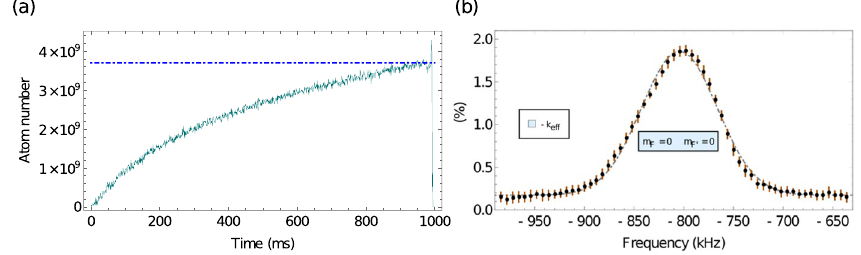
Figure 8. 3D MOT loading rate and temperature determination. ( a ) Loading rate of the 3D MOT. At one second, we measure 3.7 × 10 9 atoms - the initial loading rate is 8.0 × 10 9 atoms. ( b ) Temperature determination after launching and cooling. We fit a Gaussian model to the distribution - the gray dot-dashed curve is the fit. Each data point, in black, is the mean of ten measurements and the error bar, in orange, is the standard deviation of those ten measurements. We measure a temperature of 2.3 μ K along the axis of the Raman beam, with no velocity preselection, using a 94 μ s π -pulse. This feature is the Δ m F = 0, − k eff Doppler sensitive transition, which appears in Fig.